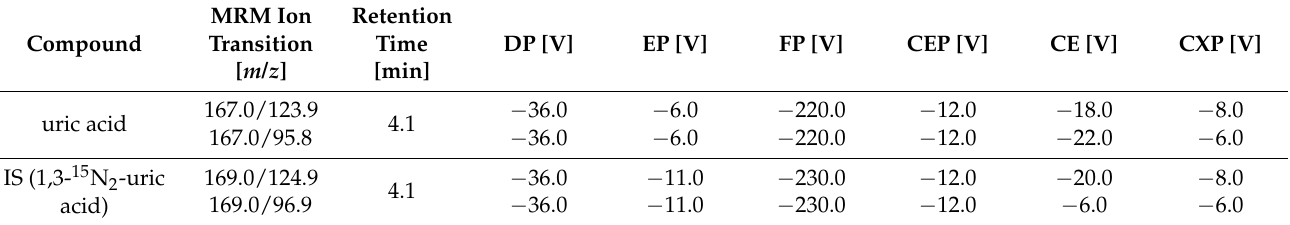
Table 6. HPLC-ESI-MS/MS (MRM) ion transitions [ m / z ], retention times [min], and